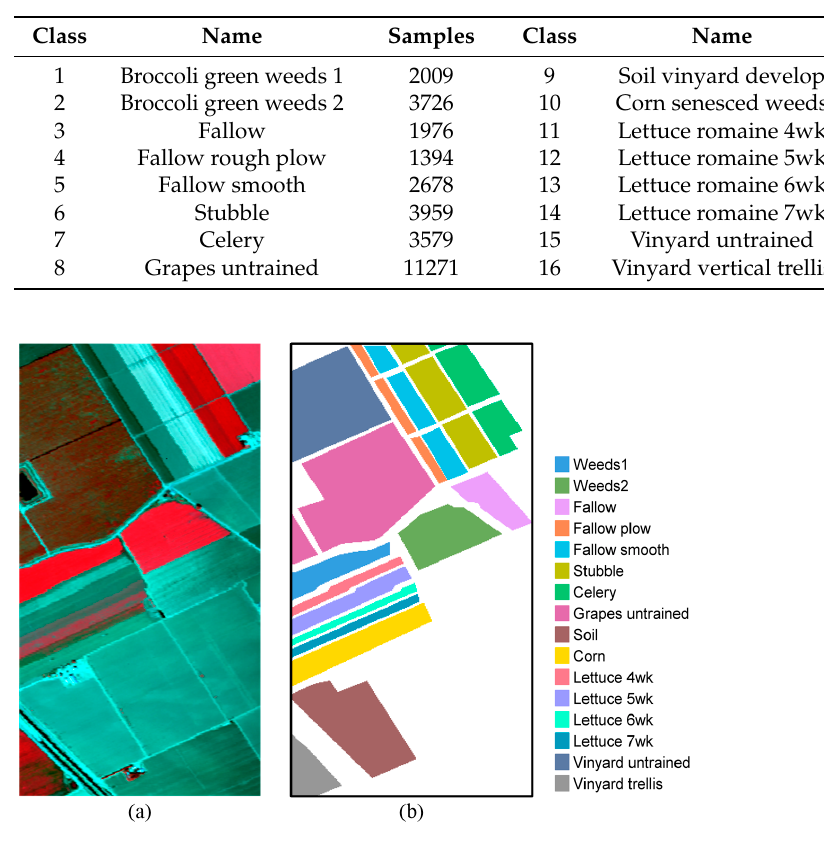
Figure 4. ( a ) False ‐ color image and ( b ) ground truth map of the Salinas data set.